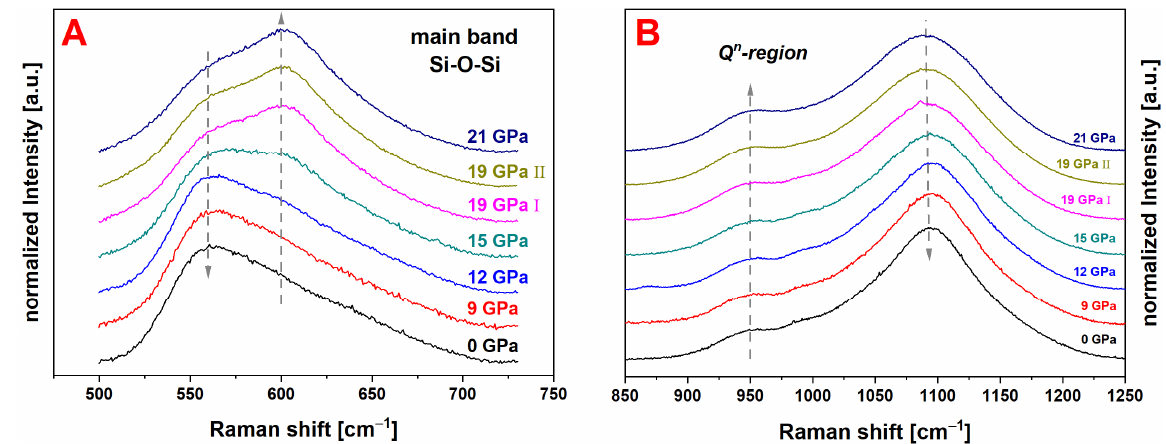
Figure 3. Raman spectra of the main band ( A ) related to Si–O–Si inter-tetrahedra angles of the permanently densified glass series (0 GPa–21 GPa); the contribution at ~560 cm − 1 decreases while the contribution at ~600 cm − 1 increases over the experimental series; spectra of the high frequency region related to the Q n -species ( B ); a ratio change of Q 3 - to Q 2 -species is observed; the large band attributed to Q 3 -species at ~1080 cm − 1 shows a decrease and a shift of the peak position to lower wavenumbers; the Q 2 -species related band at ~950 cm − 1 increases as well as the less pronounced Q 4 -band at ~1200 cm − 1 ; to evaluate the spectral variations the main band as well as the Q n -region was evaluated using the centroid parameter according to Equation (2).